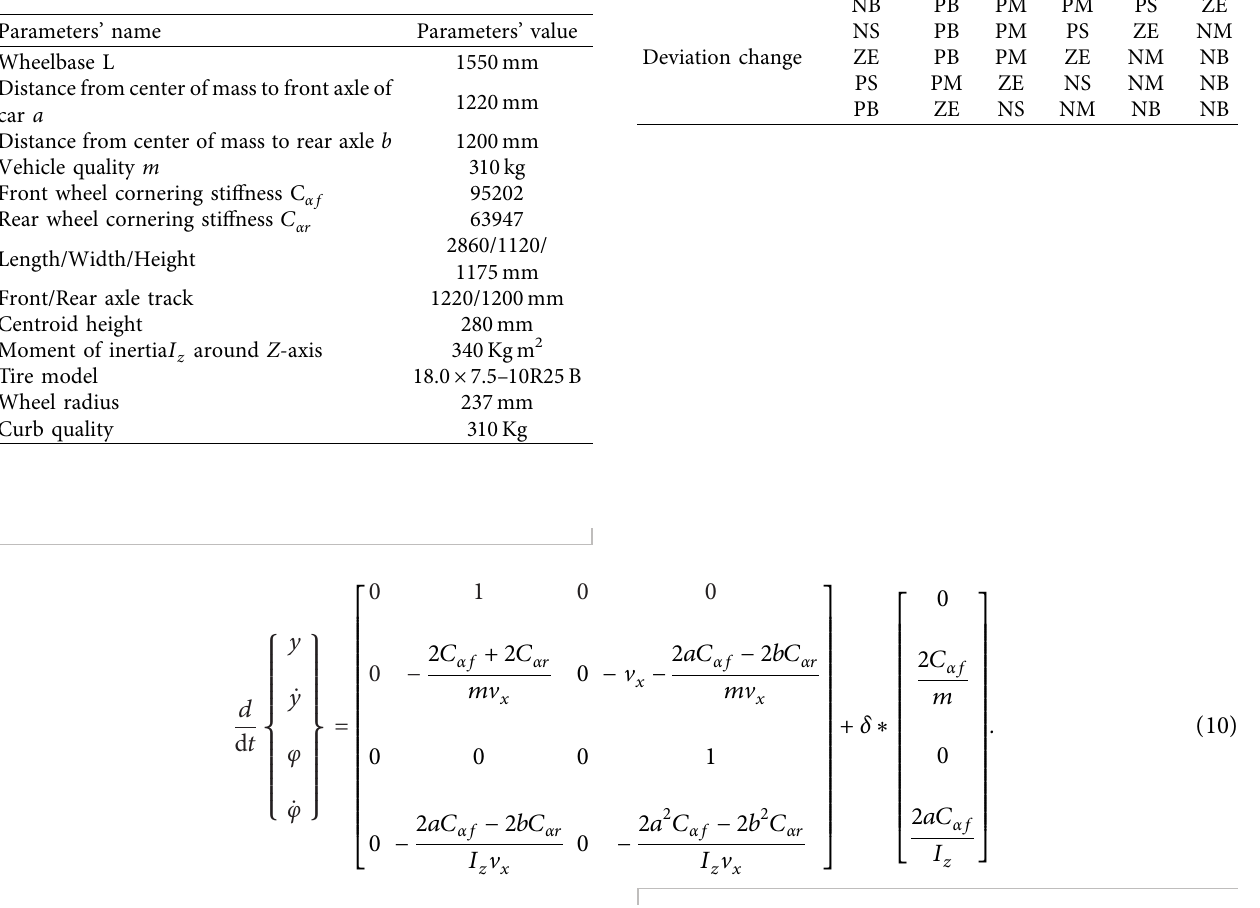
Figure 3: Side slip angle of driverless car tires. Table 1: Parameters of driverless car.